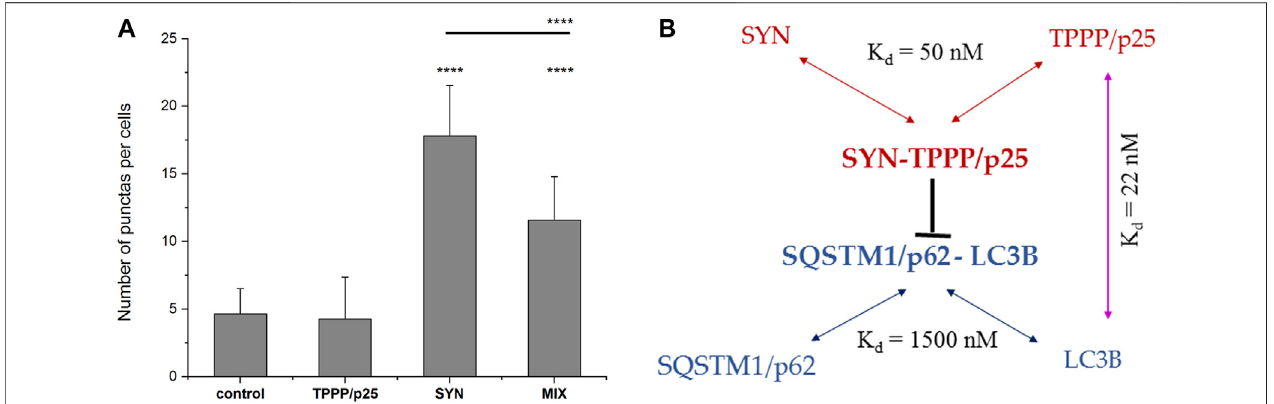
FIGURE 3 | Interactions of the markers of autophagy and the hallmarks of PD. (A) Quanti fi cation of the effects of SYN and/or TPPP/p25 on the co-localization of LC3B (mRFP-tagged LC3B expressed by transient transfection) and the endogenous SQSTM1/p62 (yellow puncta) (as shown by a representative image in Figure 2 ). Statisticalcomparisonswereperformedwithone-wayANOVAfollowedbyTukey ’ stest.Numberofpunctaspercells:**** p < 0.0001forcontrolvs.SYNorMIX,andSYN vs. MIX. (B) The results obtained for the mutual interactions of the autophagy markers and the hallmark proteins are summarized in the scheme. K d (cid:2) 1500 nM for the interaction of SQSTM1/p62 and LC3B (Novak et al., 2010).